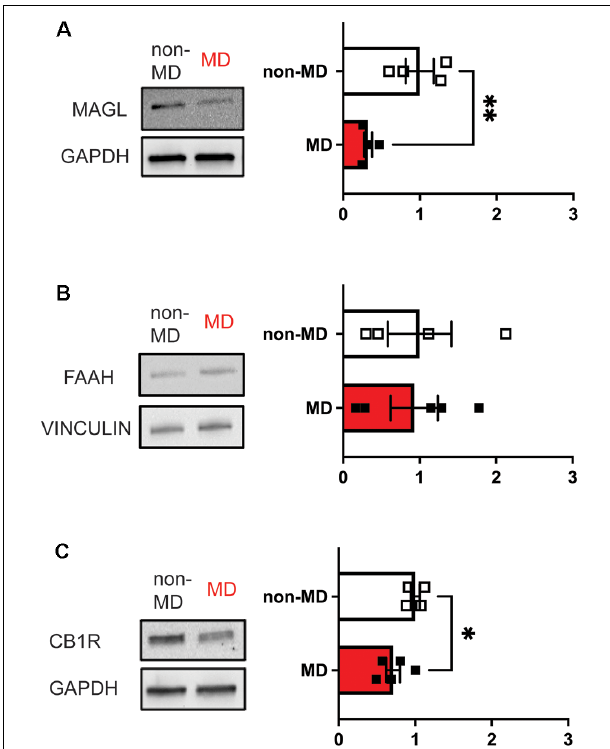
FIGURE 1 | Maternal deprivation (MD) decreases the abundance of both MAGL and CB1R in LHb whole protein lysates, but not FAAH in adulthood (Postnatal days 70–80) in response to ELS at Postnatal day 9. Bar graphs represent fold changes in the abundance of protein with respect to non-MD rats. (A) MD decreases total MAGL abundance (non-MD, n = 4; MD, n = 4; t (6) = 3.543). (B) MD does not significantly affect FAAH abundance (non-MD, n = 4; MD, n = 5; t (7) = 0.1360). (C) MD decreases CB1R abundance (non-MD, n = 4; MD, n = 5; t (7) = 2.522). ∗ p < 0.05, ∗∗ p < 0.01 by unpaired t